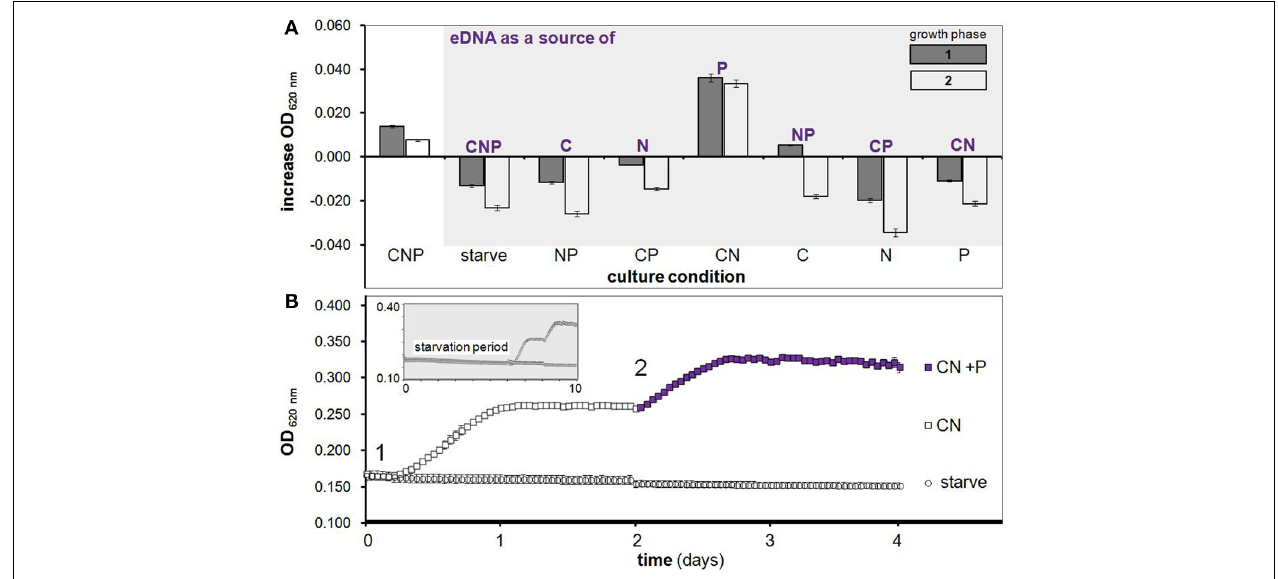
FIGURE 1 | H. volcanii growth on eDNA as a C, N and/or P source. (A) Increase in OD during two growth phases after starvation (as in growth curve below) with eDNA supplementation in Hv-min medium containing all possible combinations of C, N and P. (B) After a 6 day starvation period (shown in smaller gray box) cultures were supplemented